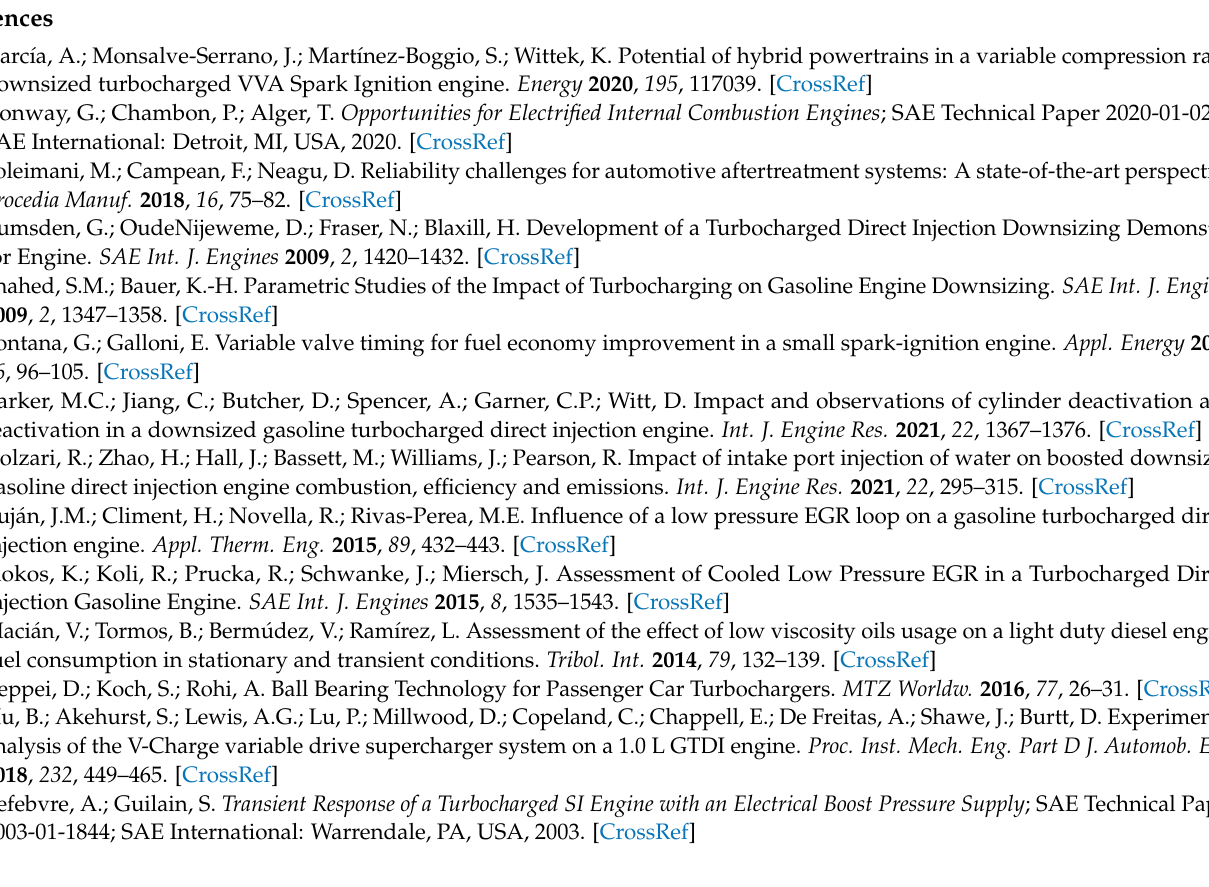
Figure A3. Time evolution of compressor outlet pressure ( a ) and its time derivative ( b ) for Case C, Case G, and a case with surge, in relation to the re-optimization of the throttle actuation for the p 1 level equal to 0.87